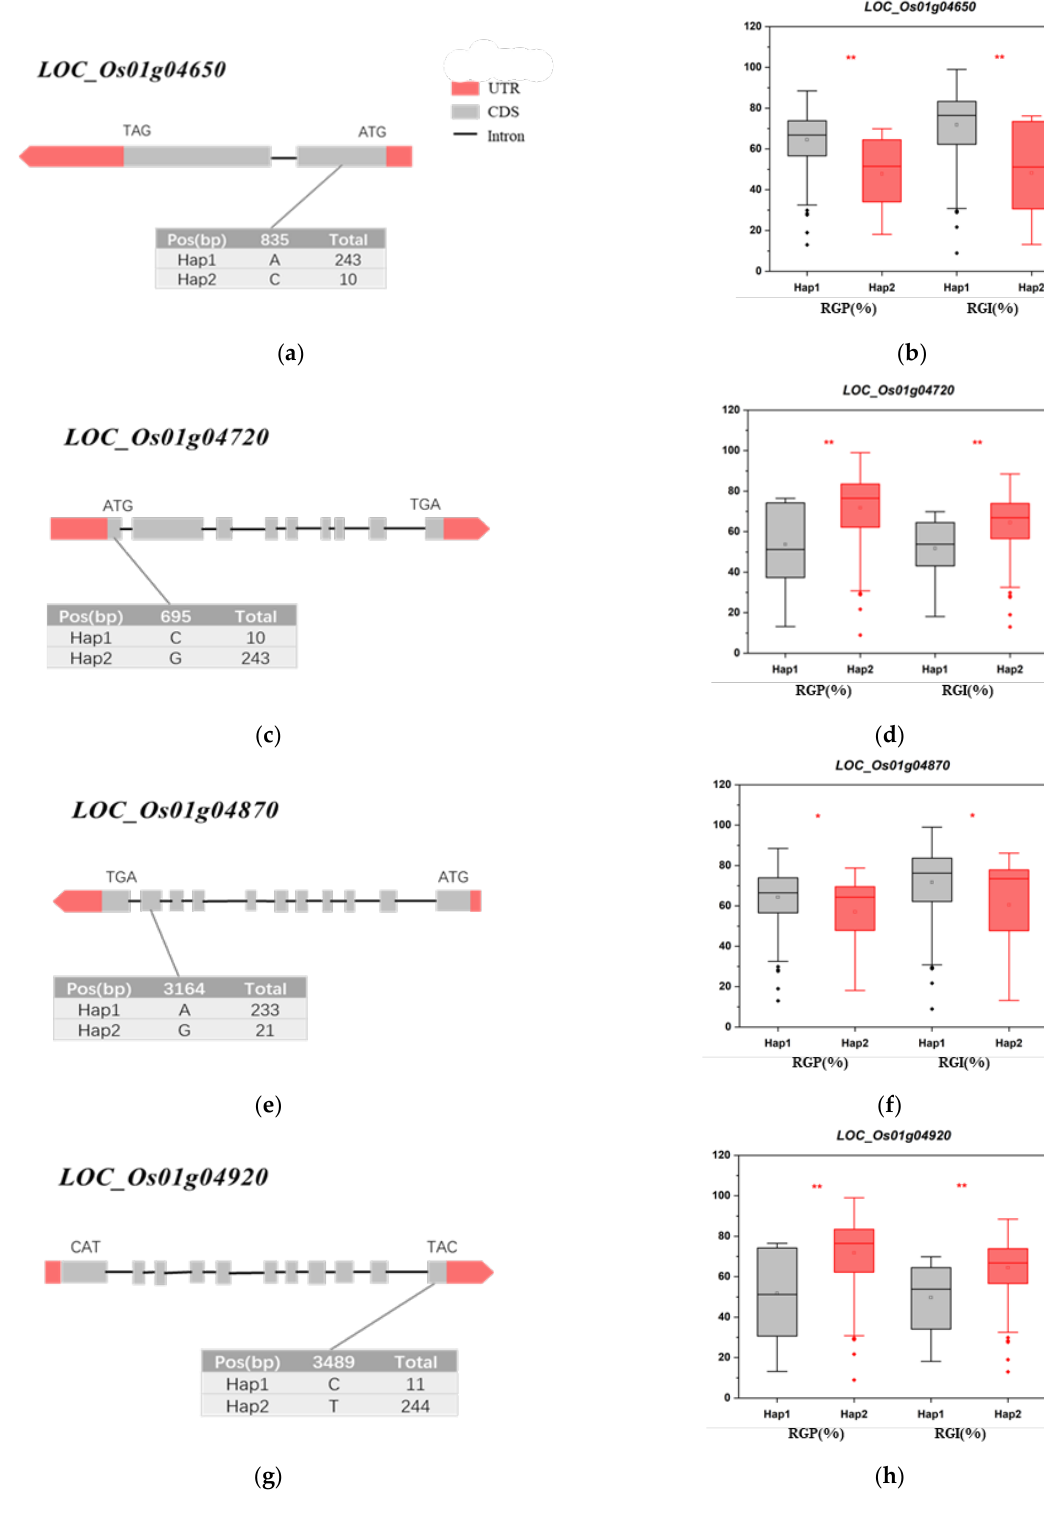
Figure 5. Gene structure and haplotype analysis. ( a , b ) represent the gene structure and haplotype analysis of LOC_Os01g04650 . ( c , d ) represent the gene structure and haplotype analysis of LOC_Os01g04720 . ( e , f ) represent the gene structure and haplotype analysis of LOC_Os01g04870 . ( g , h ) represent the gene structure and haplotype analysis of LOC_Os01g04920 . The * and ** suggest significance of ANOVA at p < 0.05 and p < 0.01, respectively.